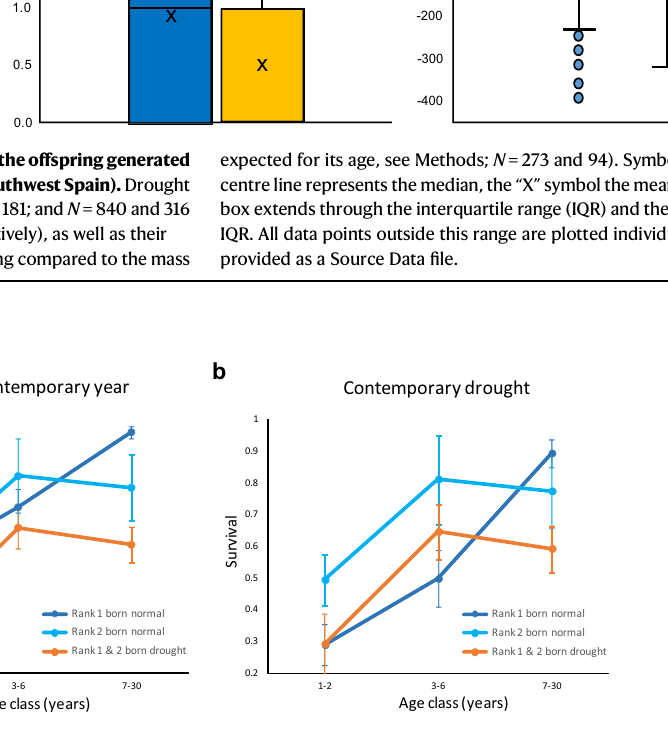
Fig. 4 | Impact of natal and current drought on the survival of the red kite population of Doñana National Park (southwest Spain). Survival through life of fi rstborn (Rank 1) and junior (Rank 2) red kite nestlings born in years of normal marsh inundation (dark blue and light blue lines for Rank 1 and Rank 2 individuals, respectively) or drought (orange lines), and when they encountered in later life a contemporary drought ( b ) or a contemporary year of normal marsh inundation ( a ).Mainresults:(1)inadults(above7yearsold,right-mostportionofbothpanels), natal drought depressed survival for all individuals, irrespective of current condi- tions (compare blue vs orange lines within each panel); (2) natal drought lowered